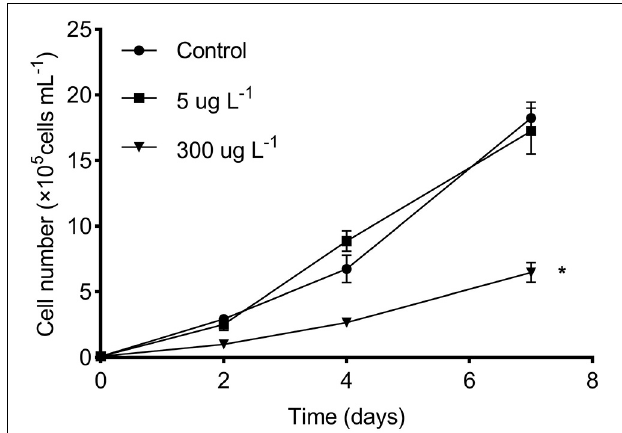
FIGURE 1 | Effects of SMX concentration on microalgal growth of R. subcapitata . The asterisk (*) indicates significant difference ( p < 0.05) between the control and SMX treatments. Data are presented as mean values ± standard deviation ( n =